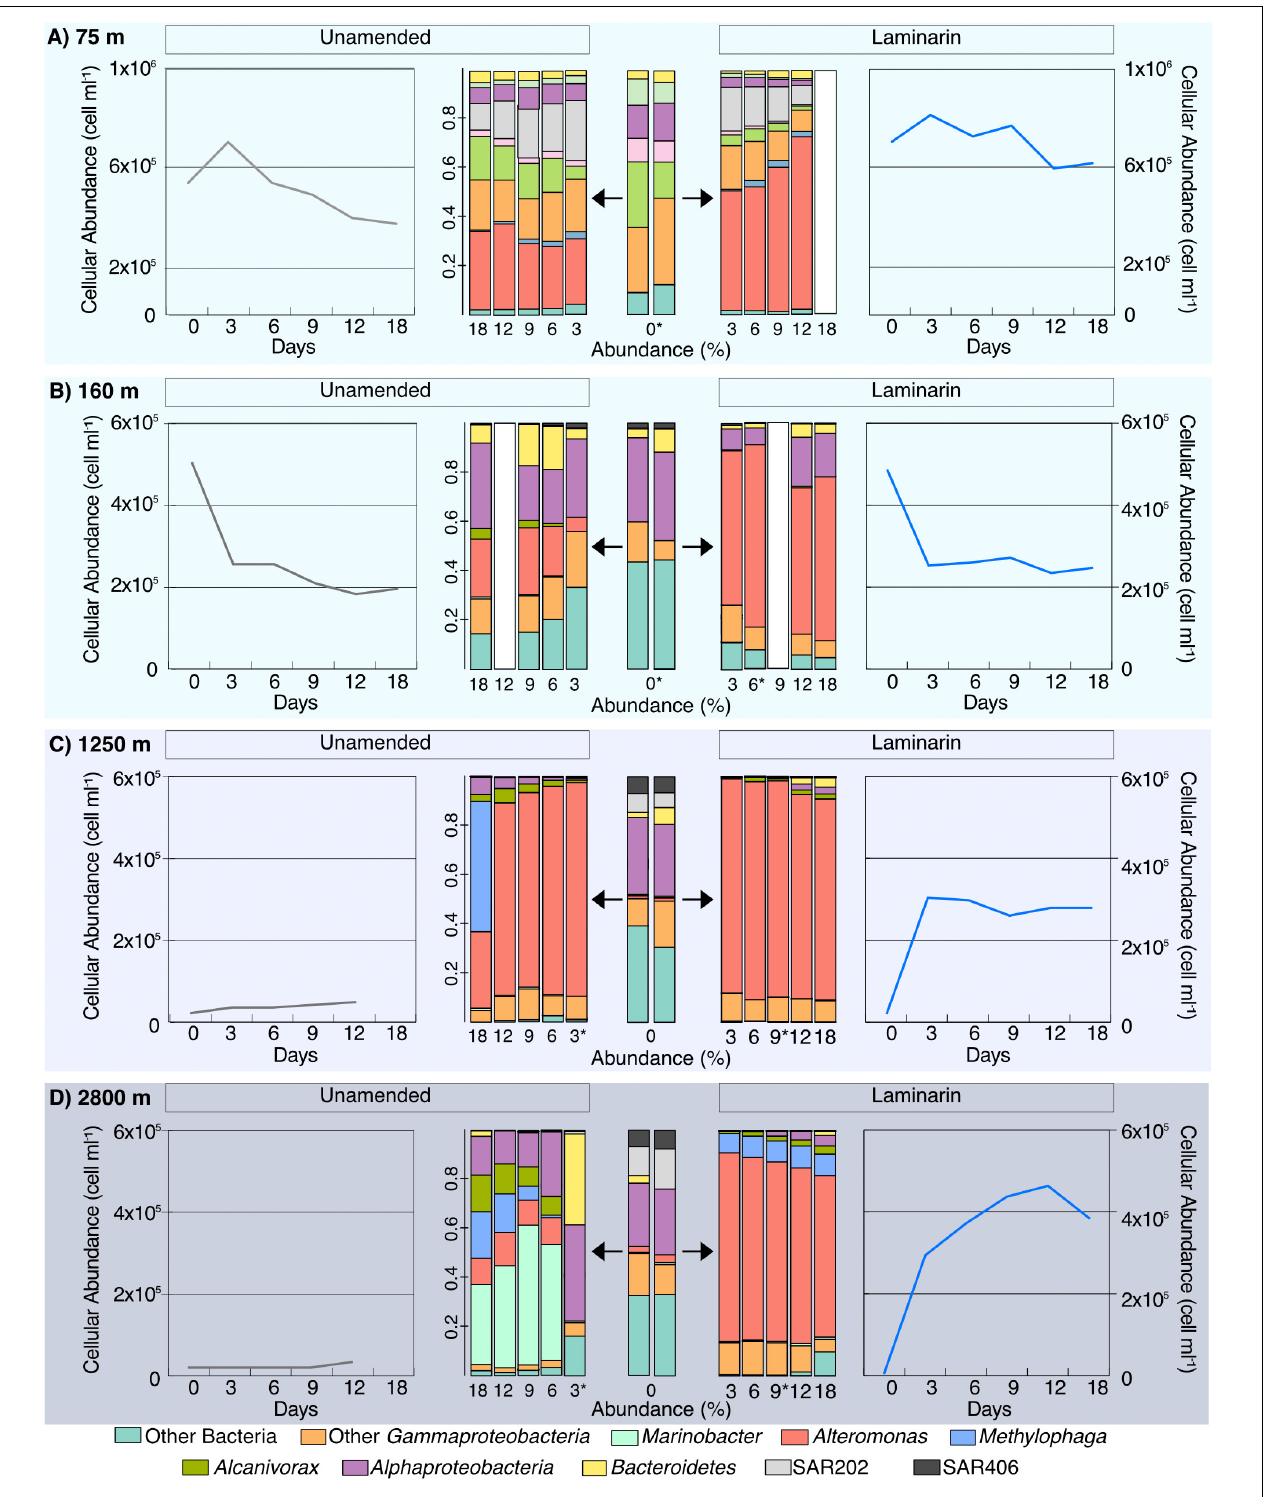
FIGURE 5 | Community composition of laminarin incubations and unamended incubations from depths of (A) 75 m; (B) 160 m; (C) 1,250 m; and (D) 2,800 m from Stn. 8. Central panels show changes in community composition with time, evolving for laminarin-amended incubations to the right, and for the unamended incubations to the left. Changes of cell counts in the same incubations, with time, flank the community composition. White bars indicate no community composition data is available and ∗ indicate samples with < 10,000 reads.